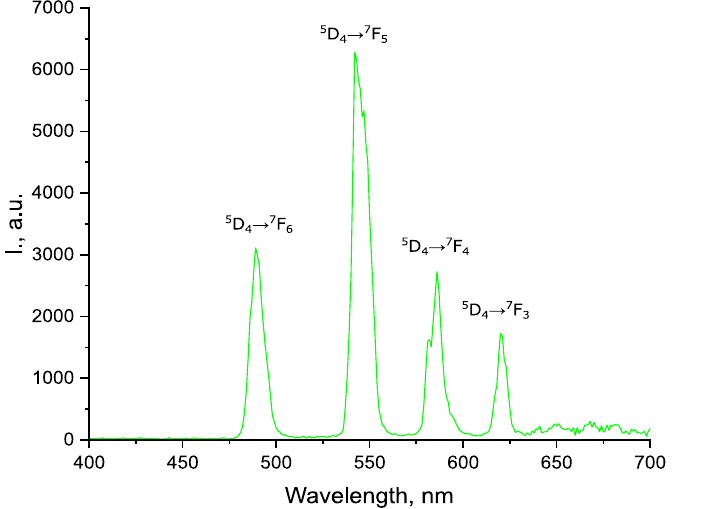
Figure 5. Terbium cation luminescence spectrum of complex Tb • 4g in water at room temperature (excitation at 317 nm).